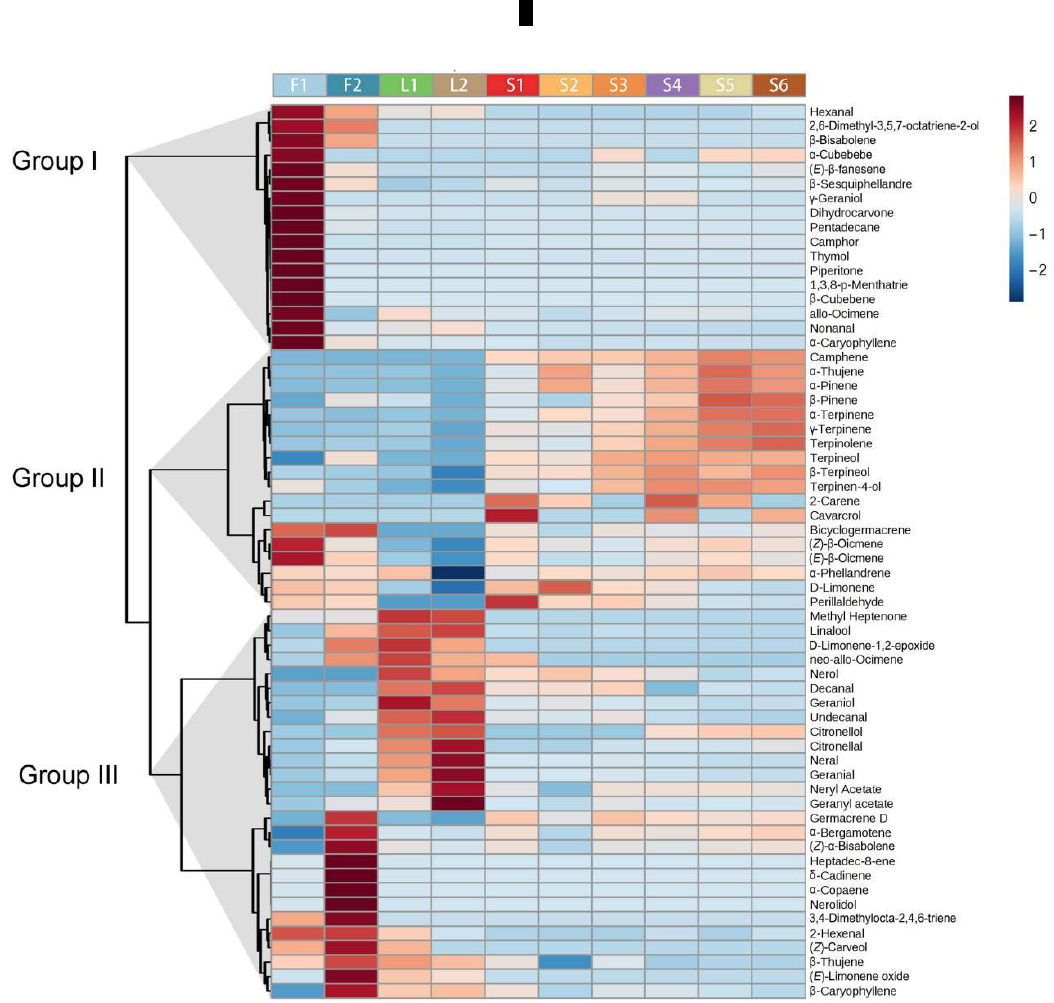
Figure 2. Hierarchical clustering and heat map visualization of changes in volatiles identified in developing finger citron. The left side of the heat map represents hierarchical clustering based on Pearson correlation. The color scale ( − 2 to 2) is shown on the right; red represents high content, blue represents low content. F1, flower bud; F2, full flower, L1, young leaf; L2, mature leaf; S1–6, fruit developing stages 1–6. Hierarchical clustering and heat map were constructed using MetaboAnalyst